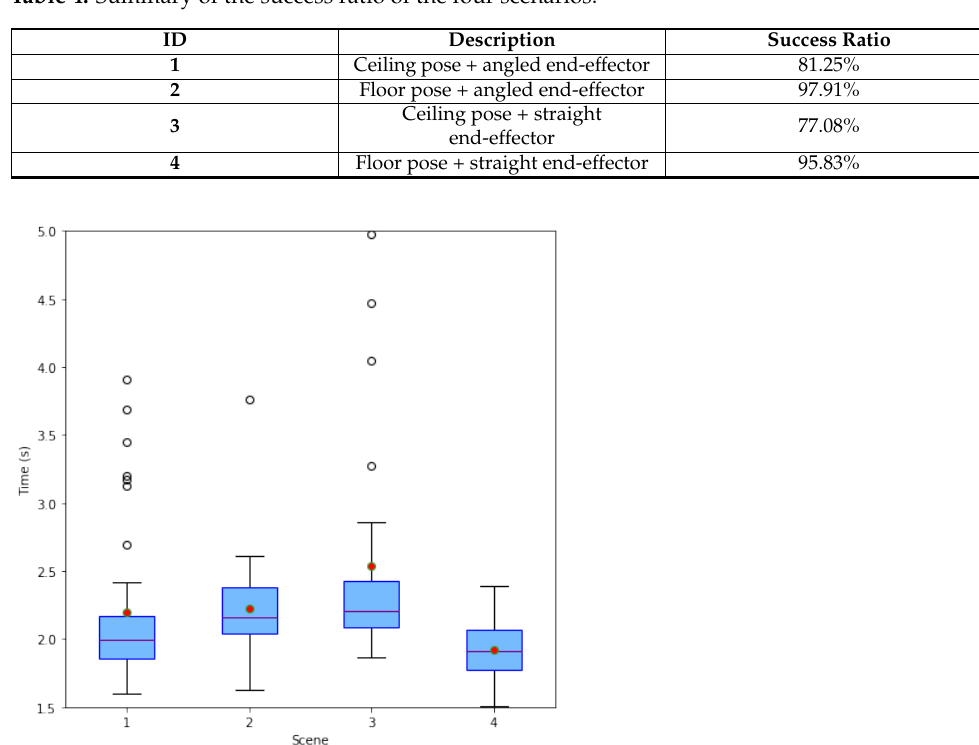
Figure 12. End effectors for the reachability study. Table 4. Summary of the success ratio of the four scenarios.